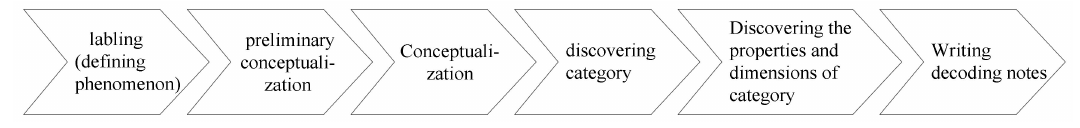
Figure 4. Process of open